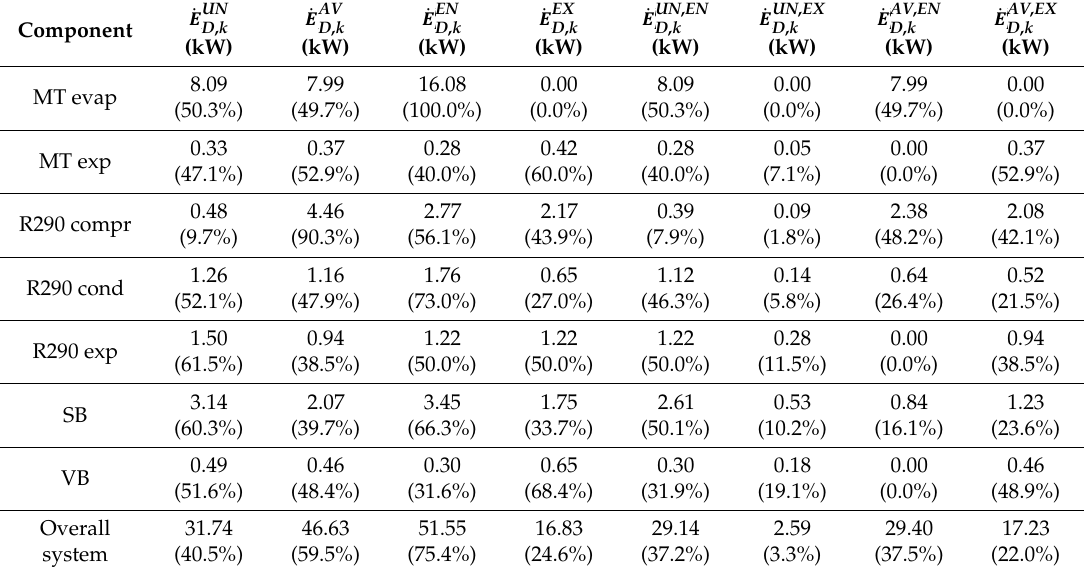
Figure 4. Breakdown of the contribution (%) of each component belonging to DMS to the total exergy destruction rate at the outdoor temperature of 40 °C. Table 8. Results related to the advanced exergy analysis for DMS at the outdoor temperature of 40 °C. Component